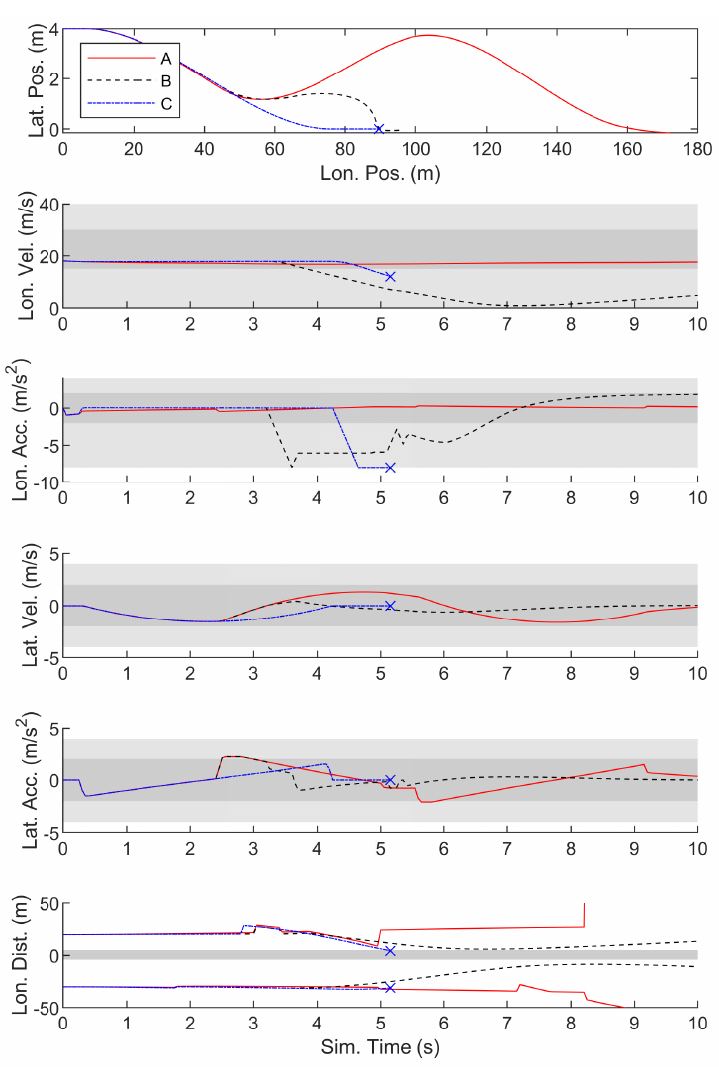
Figure 8. Simulation results for Scenario II. From top to bottom, the graphs of host vehicle V H are: 2-D trajectory, longitudinal velocity, longitudinal acceleration, lateral position, lateral velocity, lateral acceleration and host vehicle’s distance to the nearest front/rear